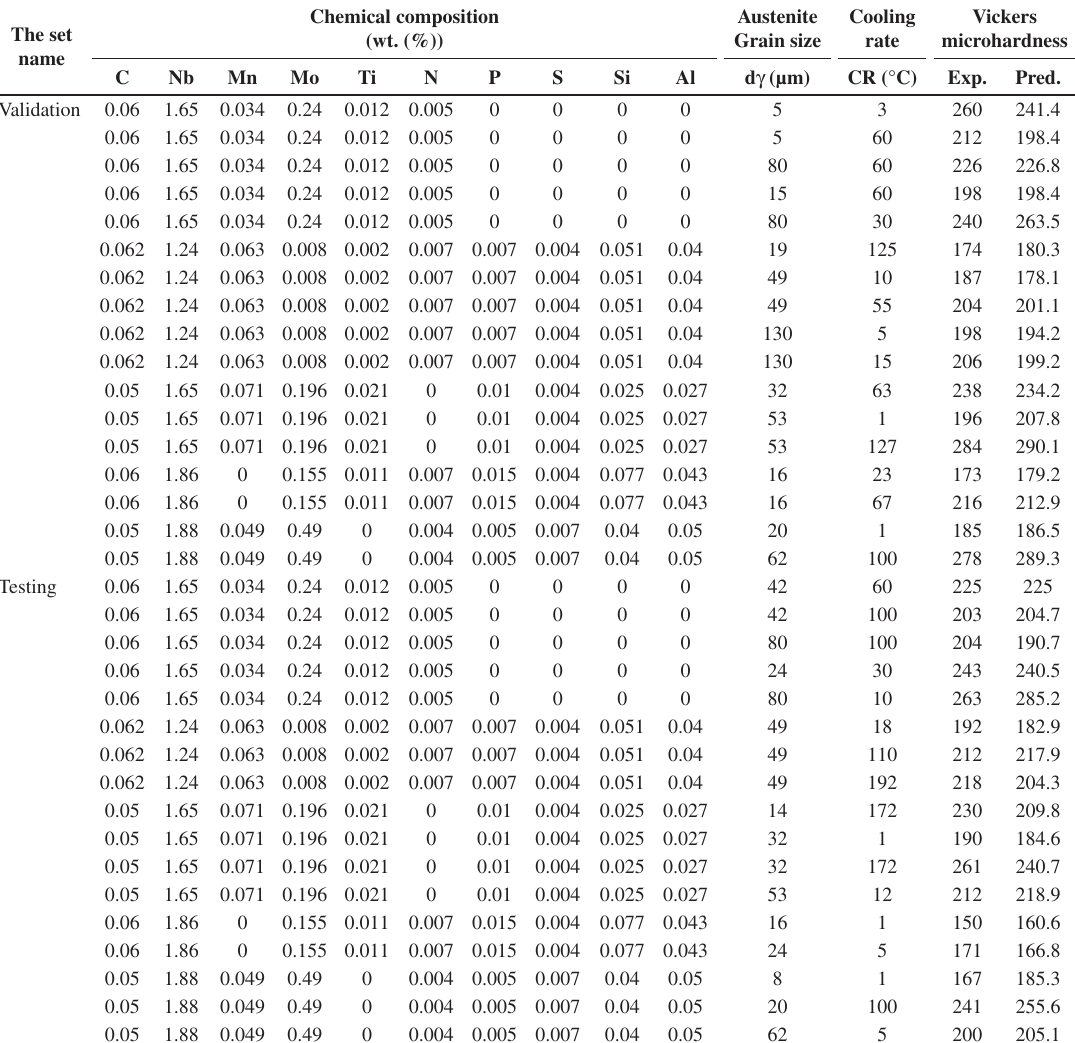
Chemical composition (wt.